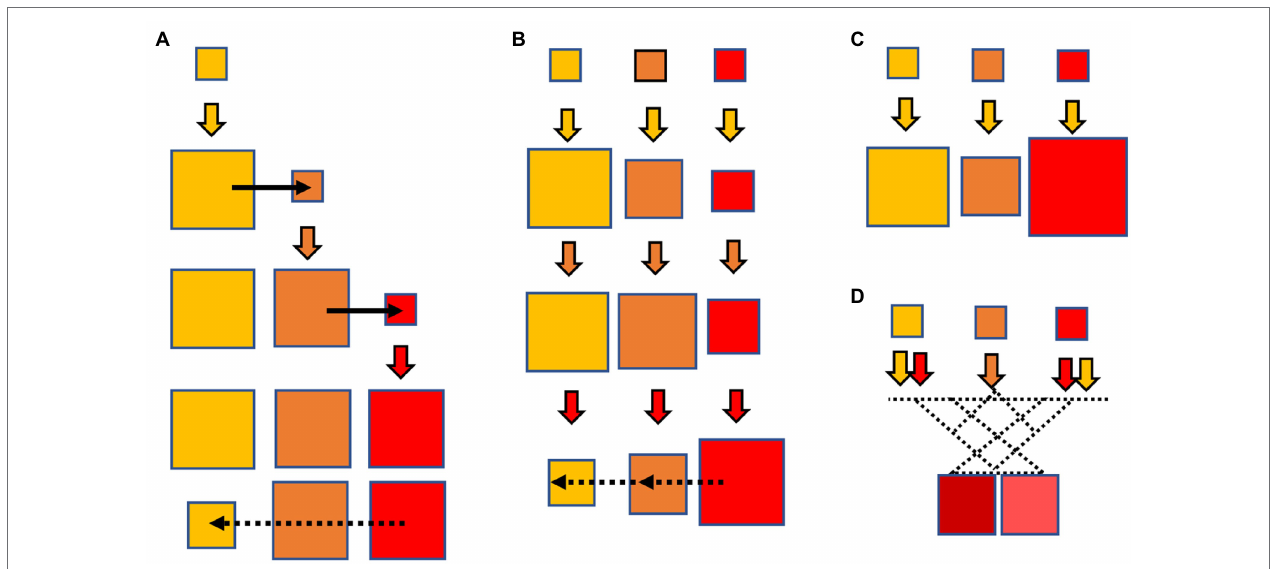
FIGURE 1 | Four cases of allogeneous selection, in which the use of an antibiotic (solid-colored arrows, the potency of the antibiotic increasing in order from yellow to brown to red) results in the emergence of mutants with resistance to other antibiotics of the same family, even the more advanced ones. (A) Collateral expansion: the yellow antibiotic expands the gene and species populations with mutational resistance to the yellow drug (yellow square), favoring the emergence of other mutations (black arrow) and inactivating the brown antibiotic; the brown antibiotic expands these populations, favoring new mutations producing resistance to the red antibiotic, which are selected by this drug. Note that this final effect starts with use of the yellow (less potent) antibiotic, and results in resistance to the red one (more potent). Eventually, resistance to the red antibiotic might reduce the efficiency of resistance to the yellow one, by antagonistic pleiotropy or collateral susceptibility (dotted black arrows). (B) Collateral selection: the yellow antibiotic selects the populations with yellow resistance but also (to a minor extent) the brown and red resistance. However, further exposure to brown and red drugs selects for these resistant populations, but the trigger of the process is the weaker antibiotic; again, collateral susceptibility might occur (dotted black arrows). (C) Collateral hyper-resistance: the yellow antibiotic selects for populations resistant to other antibiotics to a higher degree than to itself. (D) Collateral evolution: when the simultaneous or sequential use of antibiotics of the same family selects for new mutational combinations with novel phenotypes, generally with higher activity or broader spectrum. In some cases, collateral selection derives from collateral